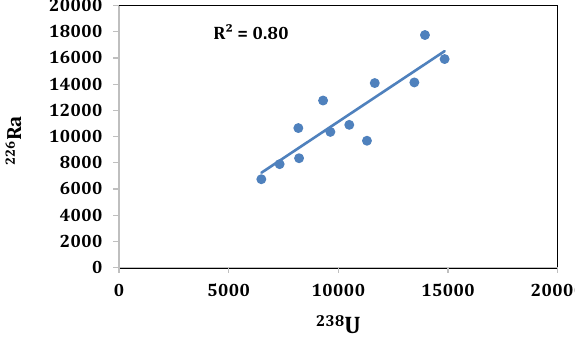
Fig. 4 Activity concentrations (Bq kg −1 ) of 226 Ra vs 238 U for different